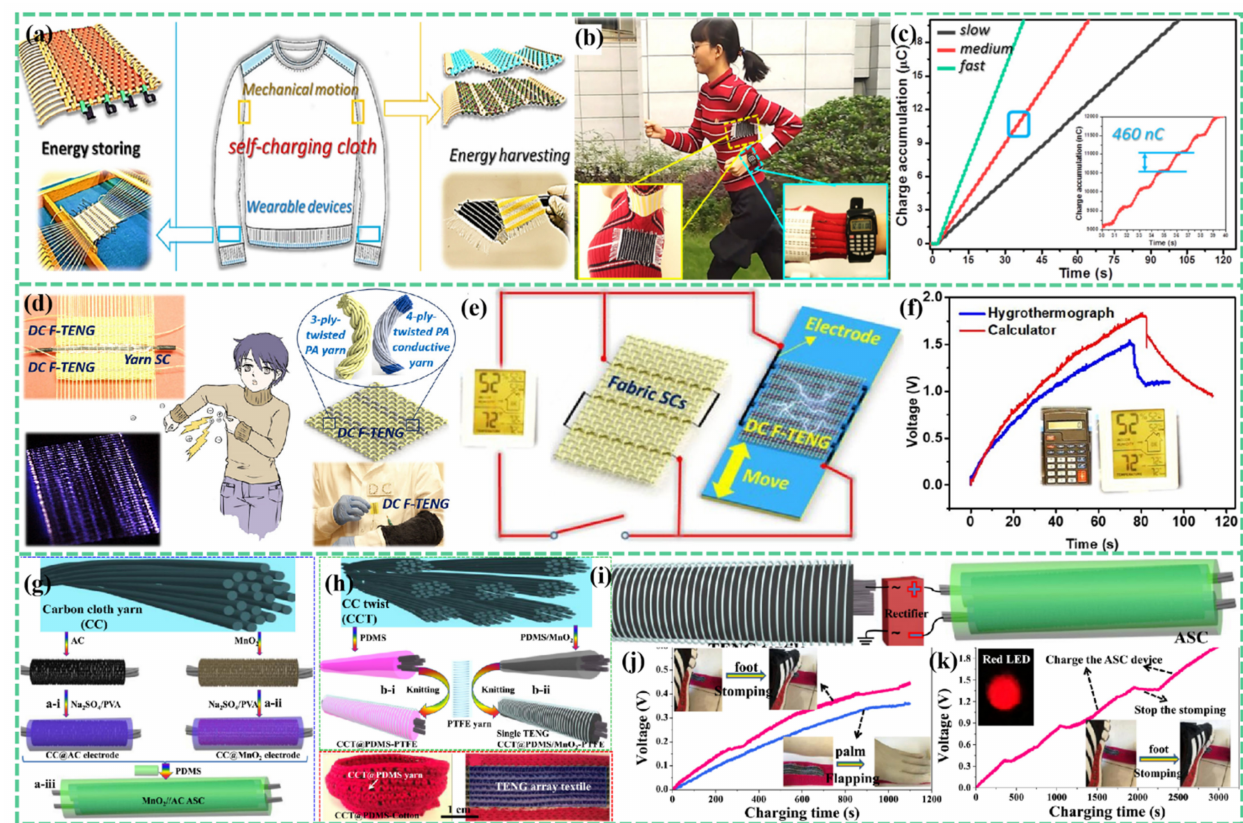
Figure 3. TENG-UPST fabricated with fiber-based TENGs and fiber-based SCs. ( a – c ) A one-piece TENG-UPST integrating a fabric TENG and woven SC for simultaneously harvesting and storing body motion energy to sustainably drive wearable electronics. ( a ) Schematic illustration of the FS- FTENG and the W-SC. ( b ) Showcase in running. ( c ) V-t curve of SCPT at 1.5 Hz operating frequency. Reproduced with permission [74]. Copyright 2018, Elsevier Ltd. ( d – f ) TENG-UPS fabric integrated with direct current TENG and fiber SCs. ( d ) Fabrication process and schematic illustration of the DC F-TENG. ( e ) Circuit diagram of the self-charging textile. ( f ) Charging curves of fabric SCs by DC F-TENG. Reproduced with permission [75]. Copyright 2018, American Chemical Society. ( g – k ) All- in-one TENG-UPST developed by integrating fiber TENG with all-solid-state fiber-based asymmetric SC. ( g ) Schematic diagram of manufacturing process of yarn type asymmetric SC. ( h ) Schematic of the round-tripping knitting process for TENGs. ( i ) Schematic diagram of the TENG-SC device. ( j ) ASC charging curve of TENG array fabric under different movements. ( k ) Charging voltage of TENG array as a function of charging time by the foot stomping motion. Reproduced with permission